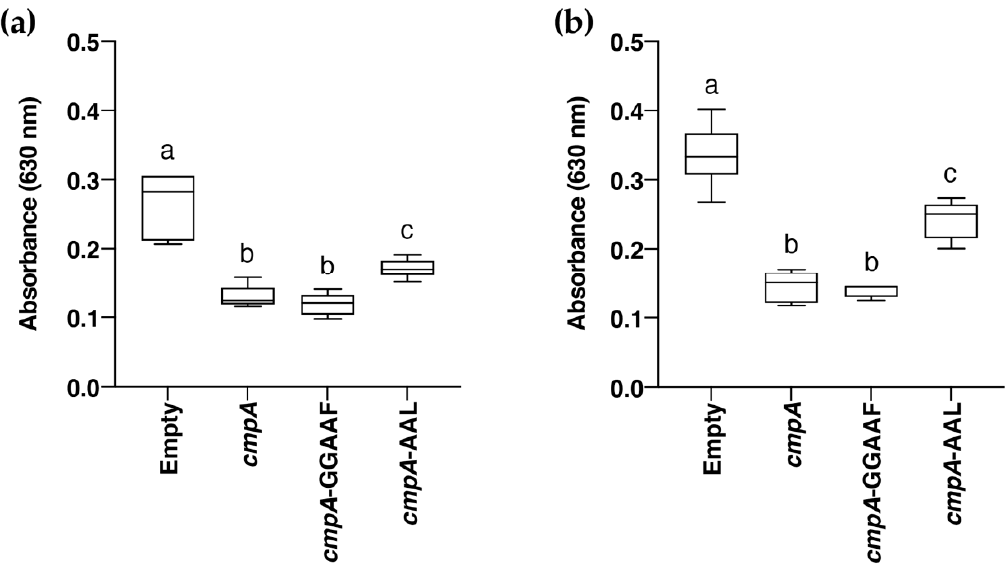
Figure 4. Biofilm formation of P. putida KT2440 overexpressing cmpA gene from P. alcaligenes AVO 110 and its mutated alleles cmpA -GGAAF and cmpA -AAL. P. putida KT2440 LB cultures were subjected to six 10-fold serial dilutions and biofilm assays were conducted on these dilutions. ( a , b ) Dilutions of 10 − 5 and 10 − 6 , respectively. Biofilm growth was determined from absorbance at 630 nm after crystal violet staining.